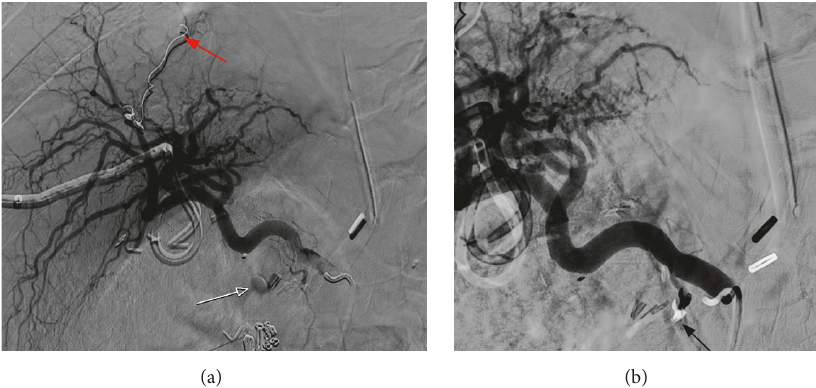
Figure 2: (a) Digital subtraction angiogram (DSA) with selective injection through the common hepatic artery shows active extravasation from a small artery arising from the gastroduodenal artery stump. The red arrow indicates previous coil embolization in the right hepatic artery branch, due to previous hepatic trauma from the prior insertion of a percutaneous transhepatic biliary drain. (b) DSA shows the embolization coil placed in the gastroduodenal artery stump with excellent hemostasis